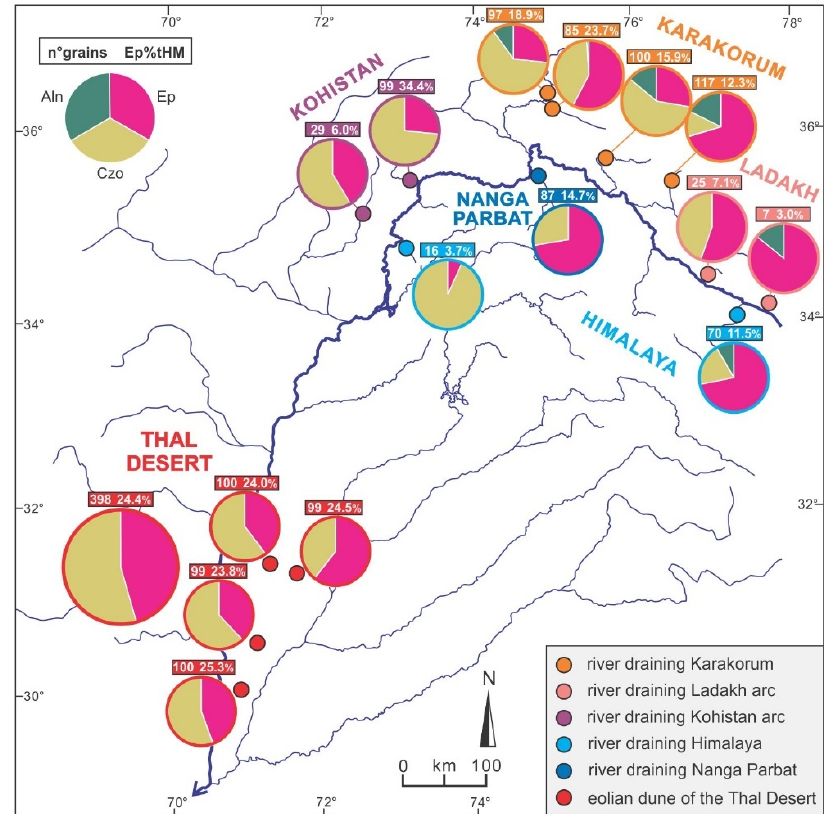
Figure 10. Calculated proportions of different varieties of detrital epidote-group minerals found in river and eolian sands of northern Pakistan. Note that Thal dunes, as well as sand from Kohistan and Nanga Parbat, lack allanite. Among Karakorum rivers, only the Hispar does not carry allanite, which singles out the Southern Karakorum as the only domain potentially representing a major source of epidote within the belt. Aln: allanite; Czo: clinozoisite; Ep: epidote.